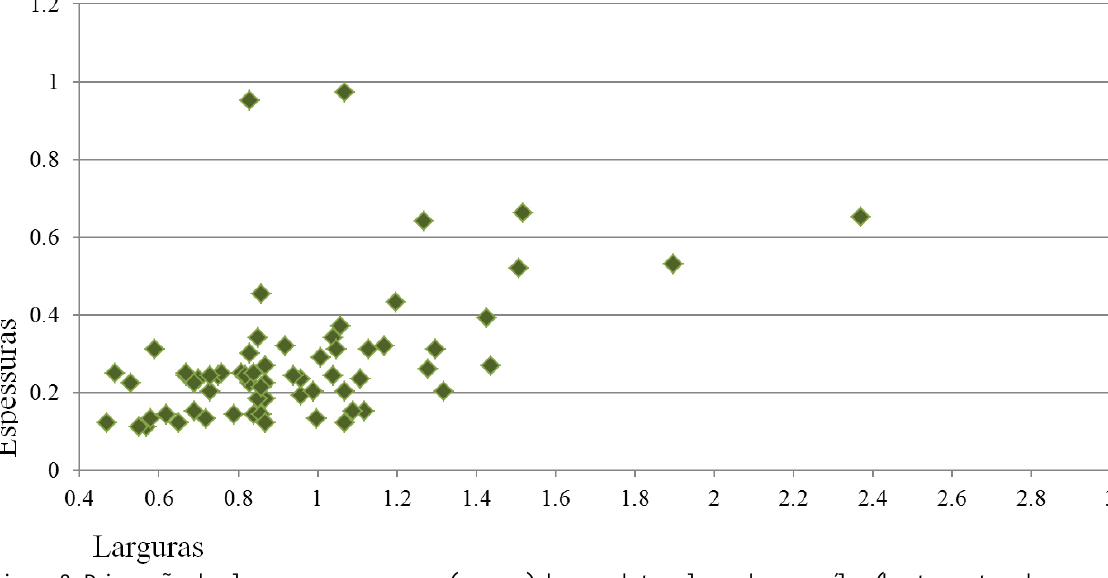
Figura 8. Dispersão das larguras e espessuras (em cm) dos produtos alongados em sílex (brutos, retocados e com sinais de uso). Figure 8. Plotting of widths and thicknesses (in cm) of flint blades or bladelets (unretouched, retouched and with use